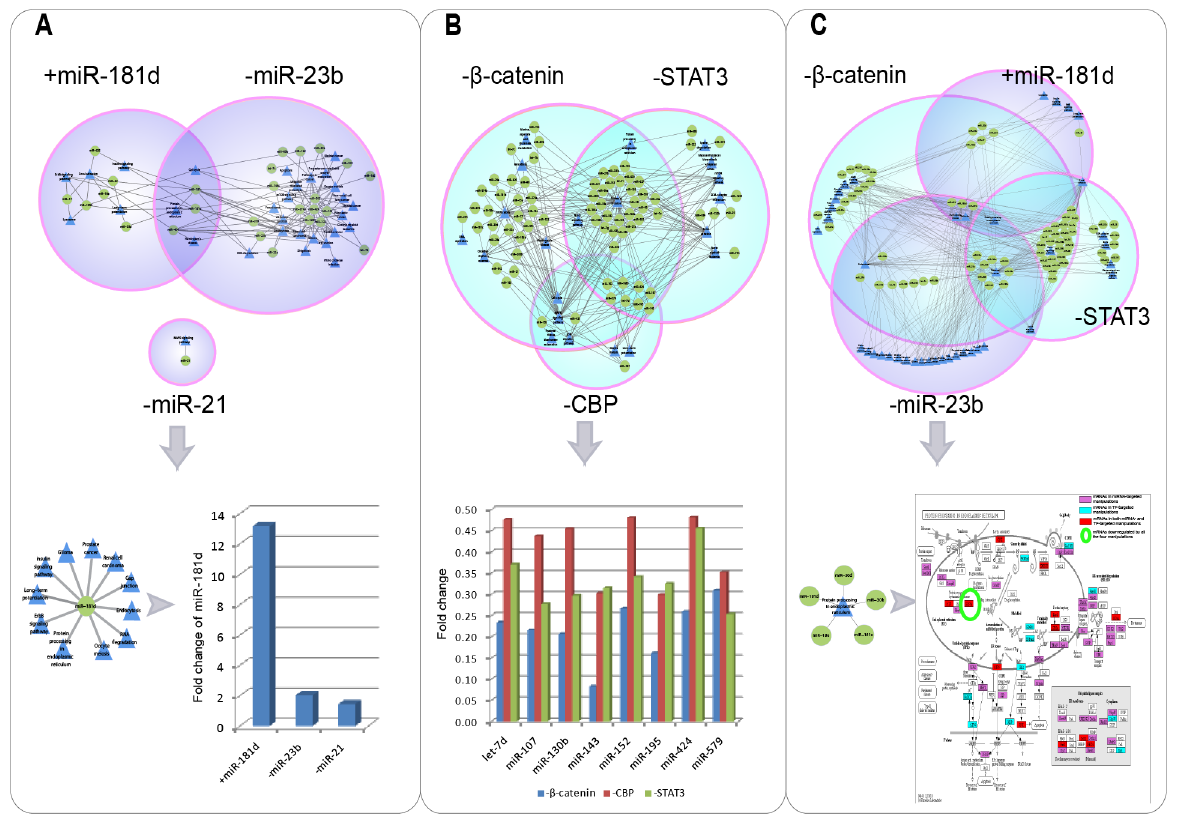
Figure 4. Functional synergy and crosstalk between MPRNs activated by different targeted manipulations. (A) Functional synergy and crosstalk between MPRNs activated by three miRNA targeted manipulations. Since miR-181d was upregulated by all the three manipulations, its target pathways and fold changes are provided. Green circles and blue triangles represent functional miRNAs and targeted pathways, respectively. (B) Functional synergy and crosstalk between MPRNs activated by three TF targeted manipulations. Since eight miRNAs were shared by all the three manipulations, their fold changes under all three manipulations are shown. (C) Example of functional synergy between MPRNs associated with manipulations targeting miRNAs and TFs. Since protein processing in the endoplasmic reticulum pathway was shared by + miR-181d, 2 miR-23b, 2 b - catenin, and 2 STAT3, miRNAs regulating this pathway are shown. The distribution of mRNAs with altered expression in this pathway is shown in the diagram, where purple, cyan, and red rectangles represent mRNAs deregulated by manipulations targeting miRNA, TFs, or both, respectively. HSP90B1 (circled in green) was downregulated by all the four experimental conditions.